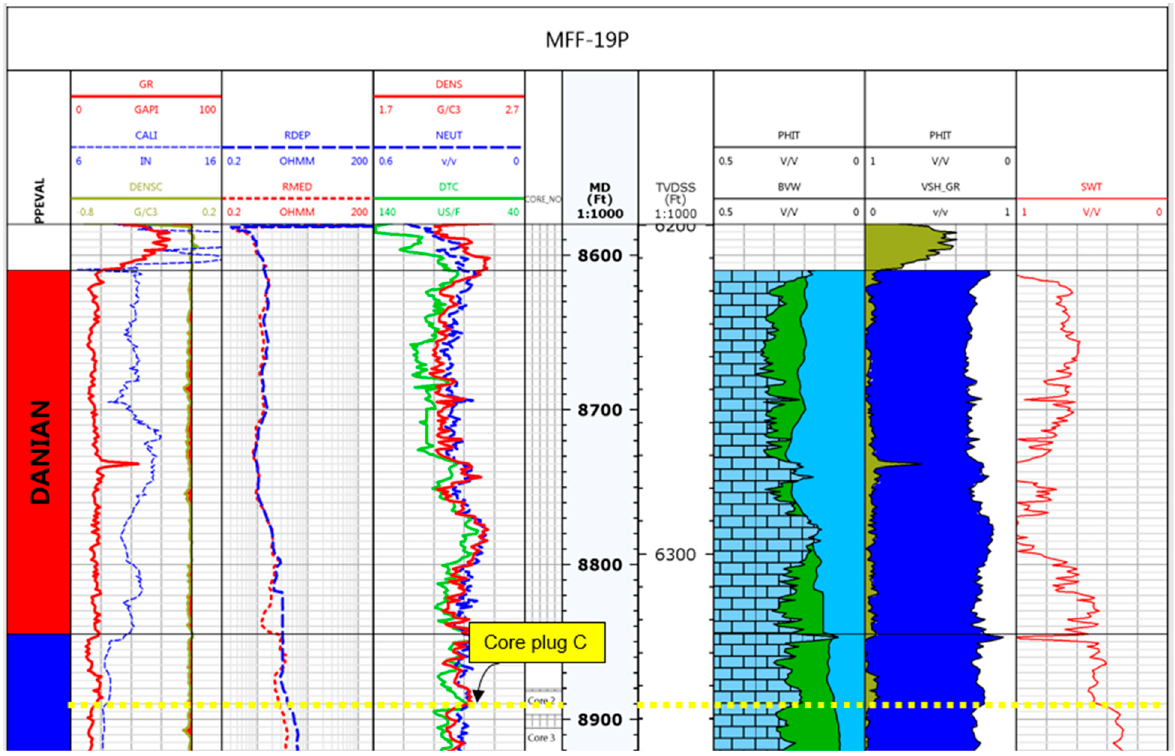
Figure 2. The measured depth (8890 ft) of core plug C from well MFF-19P, Maastrichtian age, Tor formation. A slice from this core plug was used in experiments 7 to 9. Table 3. Petrophysical characteristics of core plugs. Length L, diameter D, permeability K, and po ‐ rosity Φ were measured before flooding studies; pore volume PV, and initial water saturation S wi.